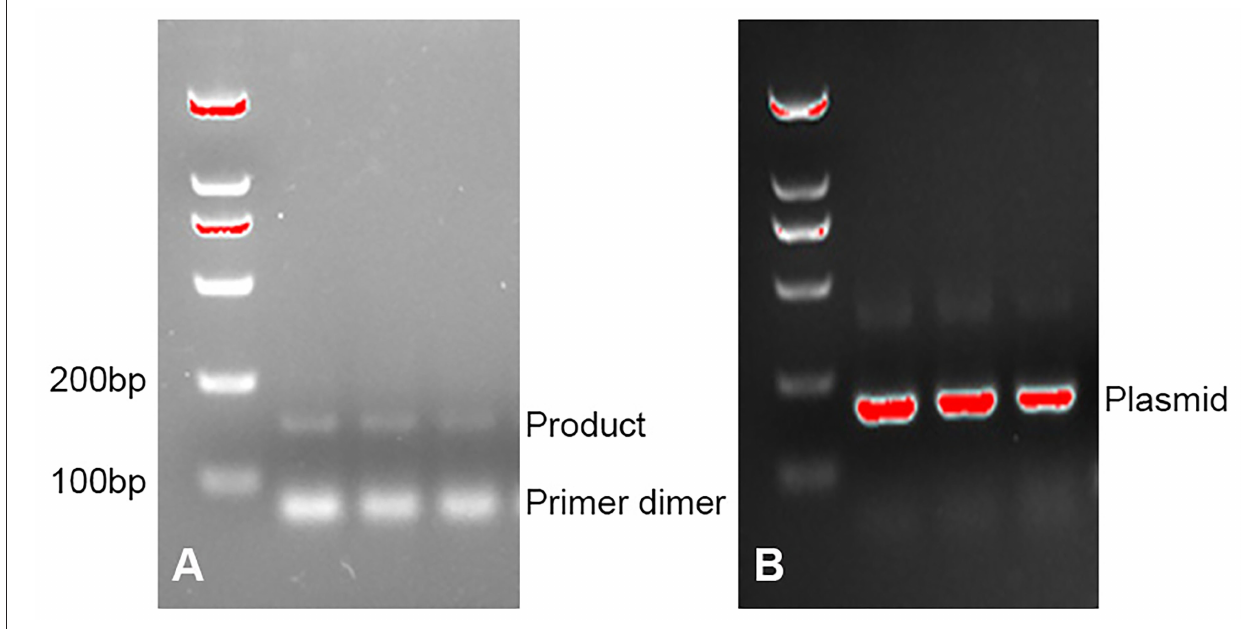
FIGURE 1 | (A) PCR detection for P. jirovecii DNA on bronchoalveolar lavage fluid (BALF) specimens. (B) PCR detection for plasmid.